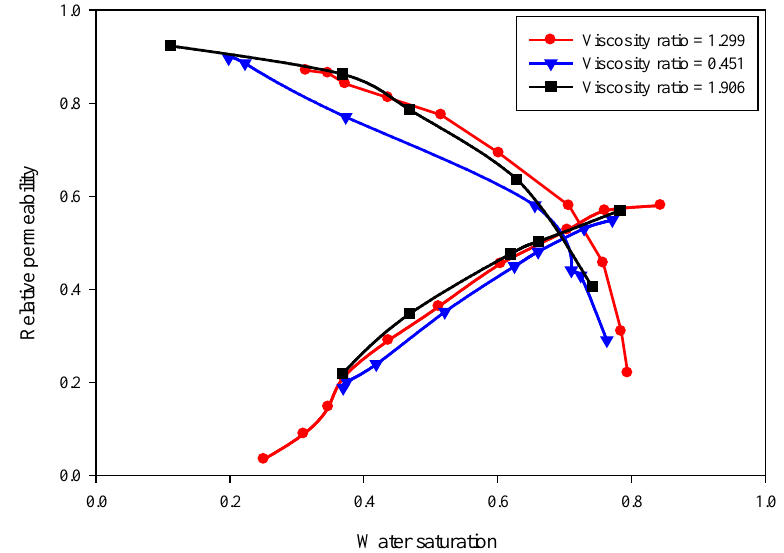
E ff ect of viscosity ratio on water / oil two-phase-relative permeability versus water Figure 4. Effect of viscosity ratio on water/oil two-phase-relative permeability versus water saturation saturation [61].